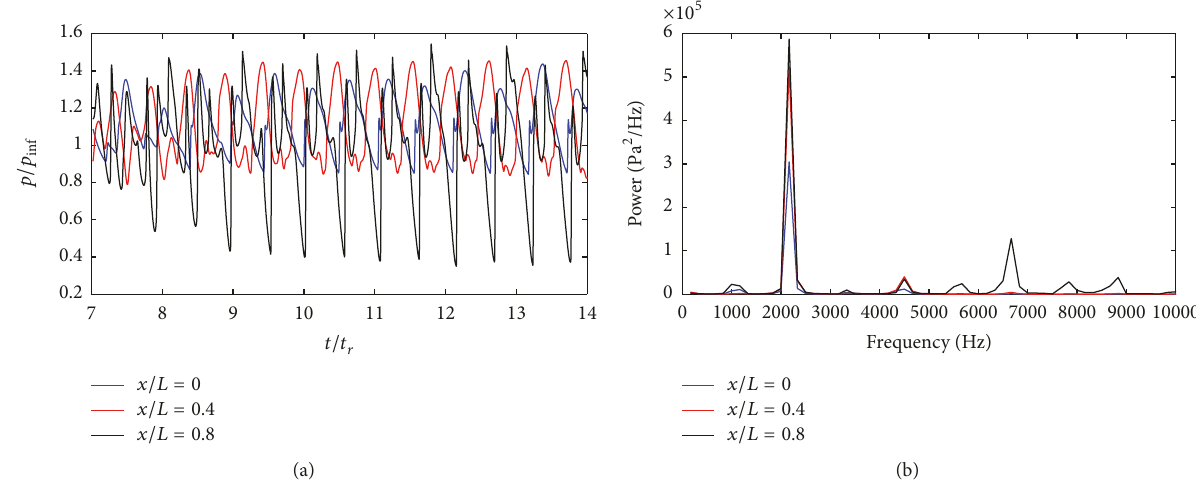
Figure 10: The results for cavity floor. (a) Pressure distribution. (b) Power spectrum for the baseline case.